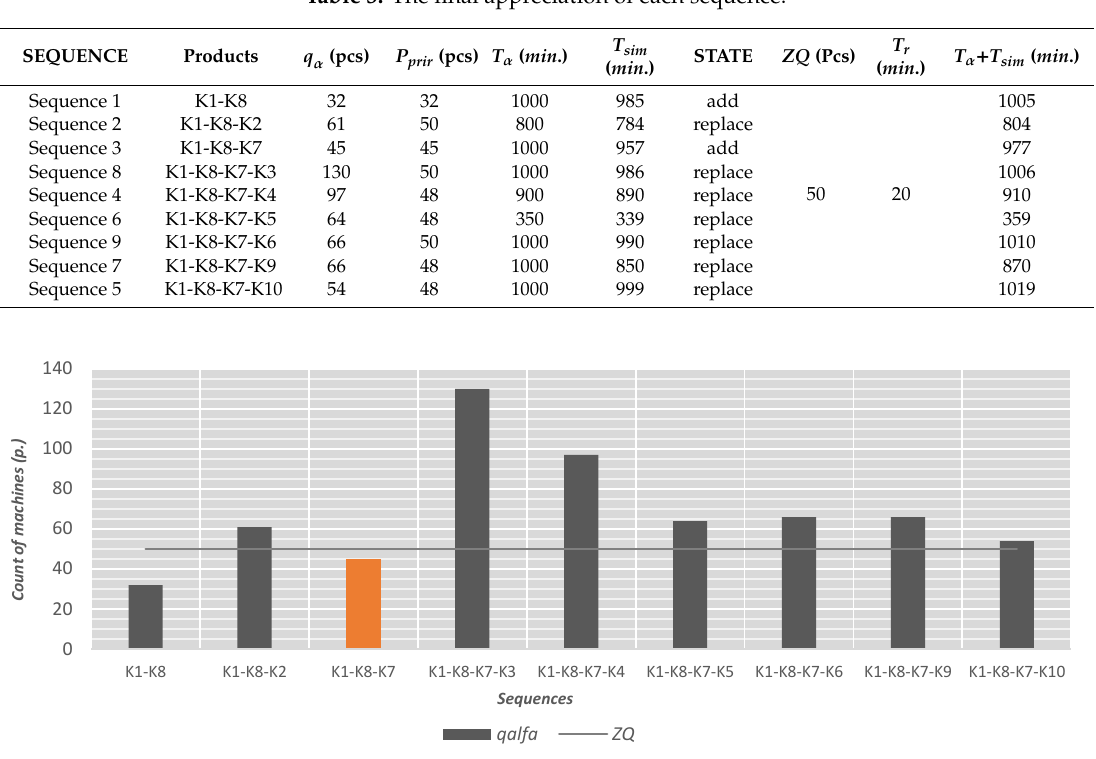
Table 3. The final appreciation of each sequence.